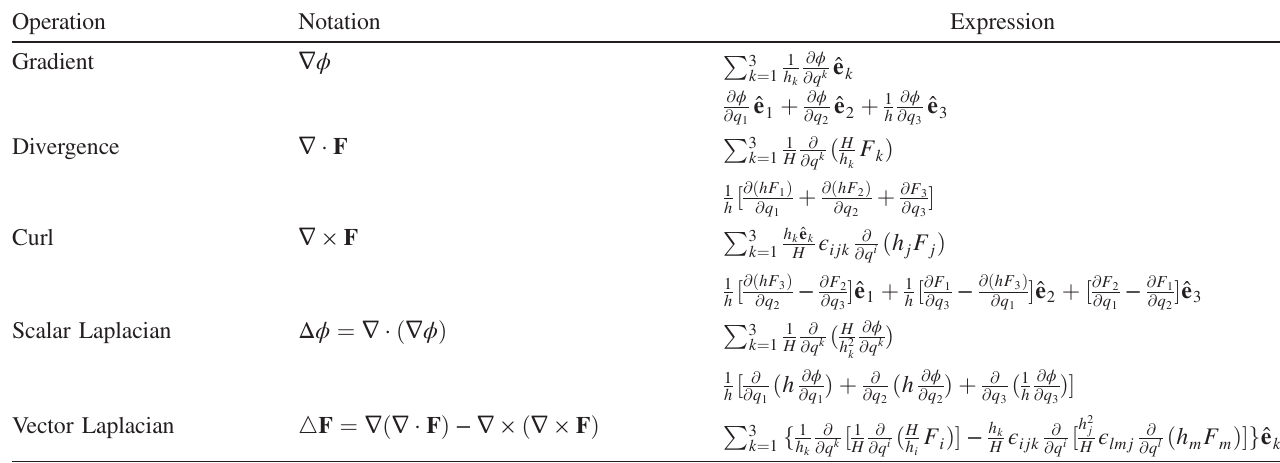
TABLE VI. Differential operators in general orthogonal coordinates ð q 1 ; q 2 ; q 3 Þ where H ¼ h 1 h 2 h 3 , and its expressions in orthogonal coordinates associated with Serret-Frenet frame.